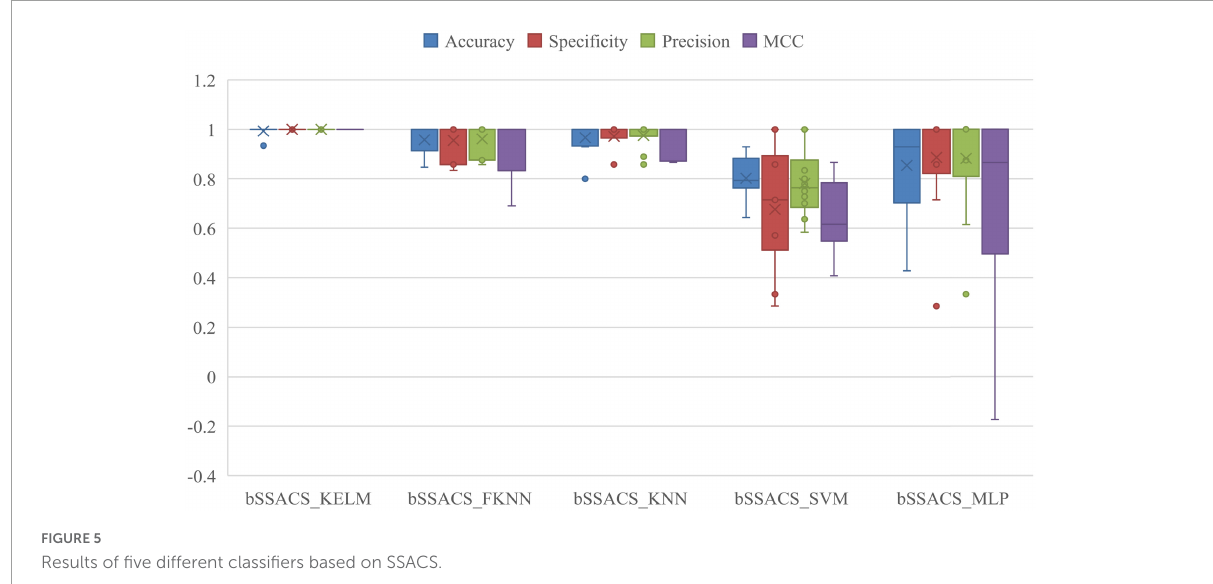
FIGURE5 Results of five different classifiers based on SSACS.